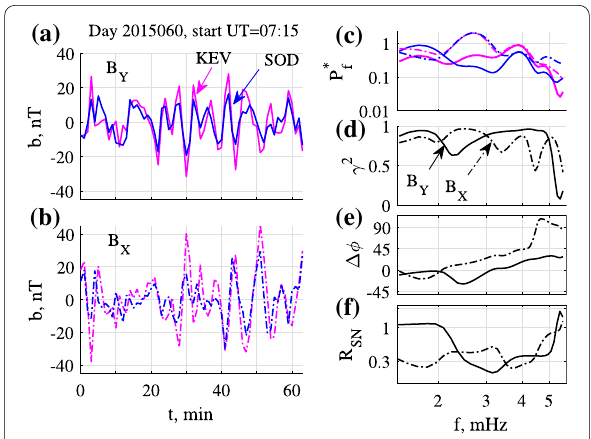
Fig. 4 Parameters of the event 1 pulsation in the N–S direction: a , b B Y and B X waveforms at KEV (magenta) and SOD (blue); c normalized PSD spectra; d , e N–S spectral coherence and phase difference for B Y (solid) and B X —(dashed); f South-to-North PSD ratio for B Y (solid) and B X - (dashed)